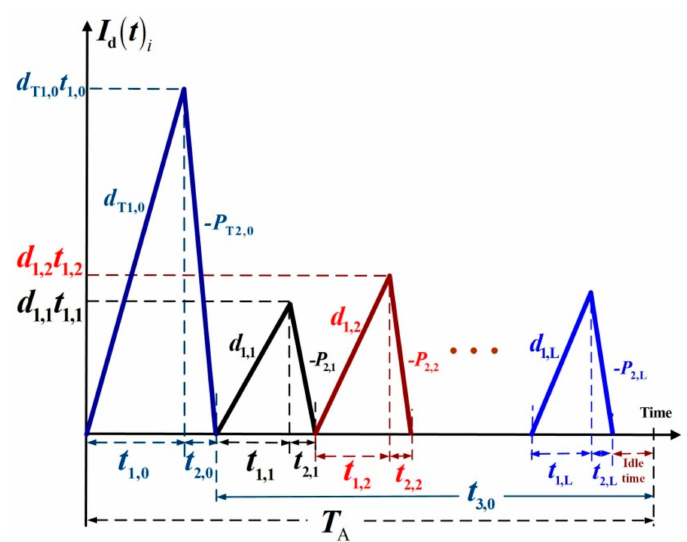
Figure 3. The level of nonconforming items of the proposed multi-item two-stage postponement